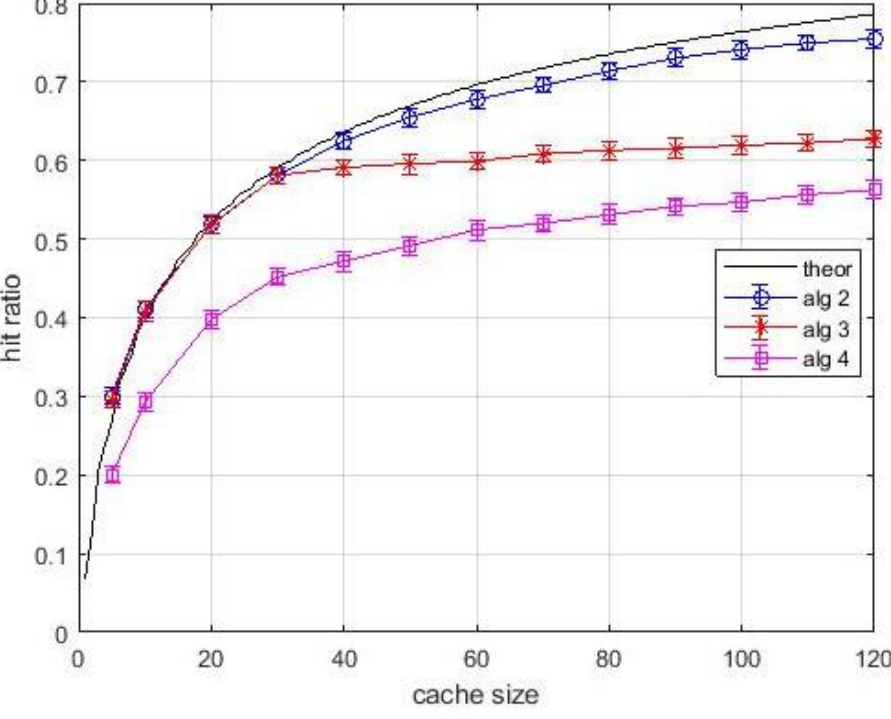
Figure 13. Hit ratio, case 4, N =